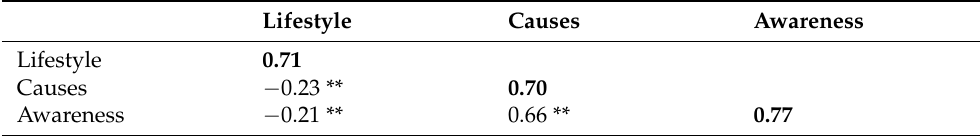
Table A3. Discriminant Validity Assessment using the Fornell-Larcker Method.